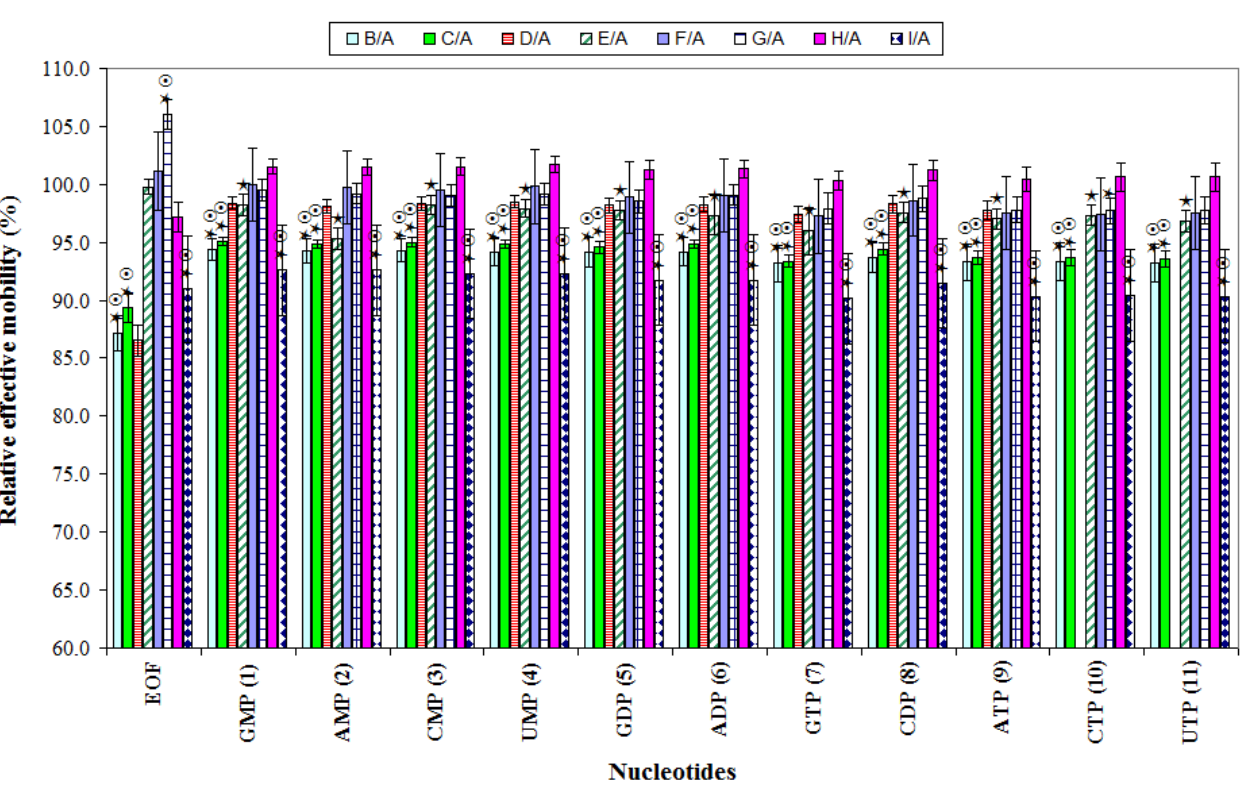
Figure 4. Relative effective mobility changes of nucleotides in capillaries with modified sol–gels compared to 100% of the capillary with pure sol–gel without additive (line A). A t -test p < 0.05 is marked by the symbol above the colored bars. The symbol indicates that the values of the effective mobility changes were greater than ±5% of the standard deviation of the Gaussian normal distribution, compared to the pure sol–gel capillary.